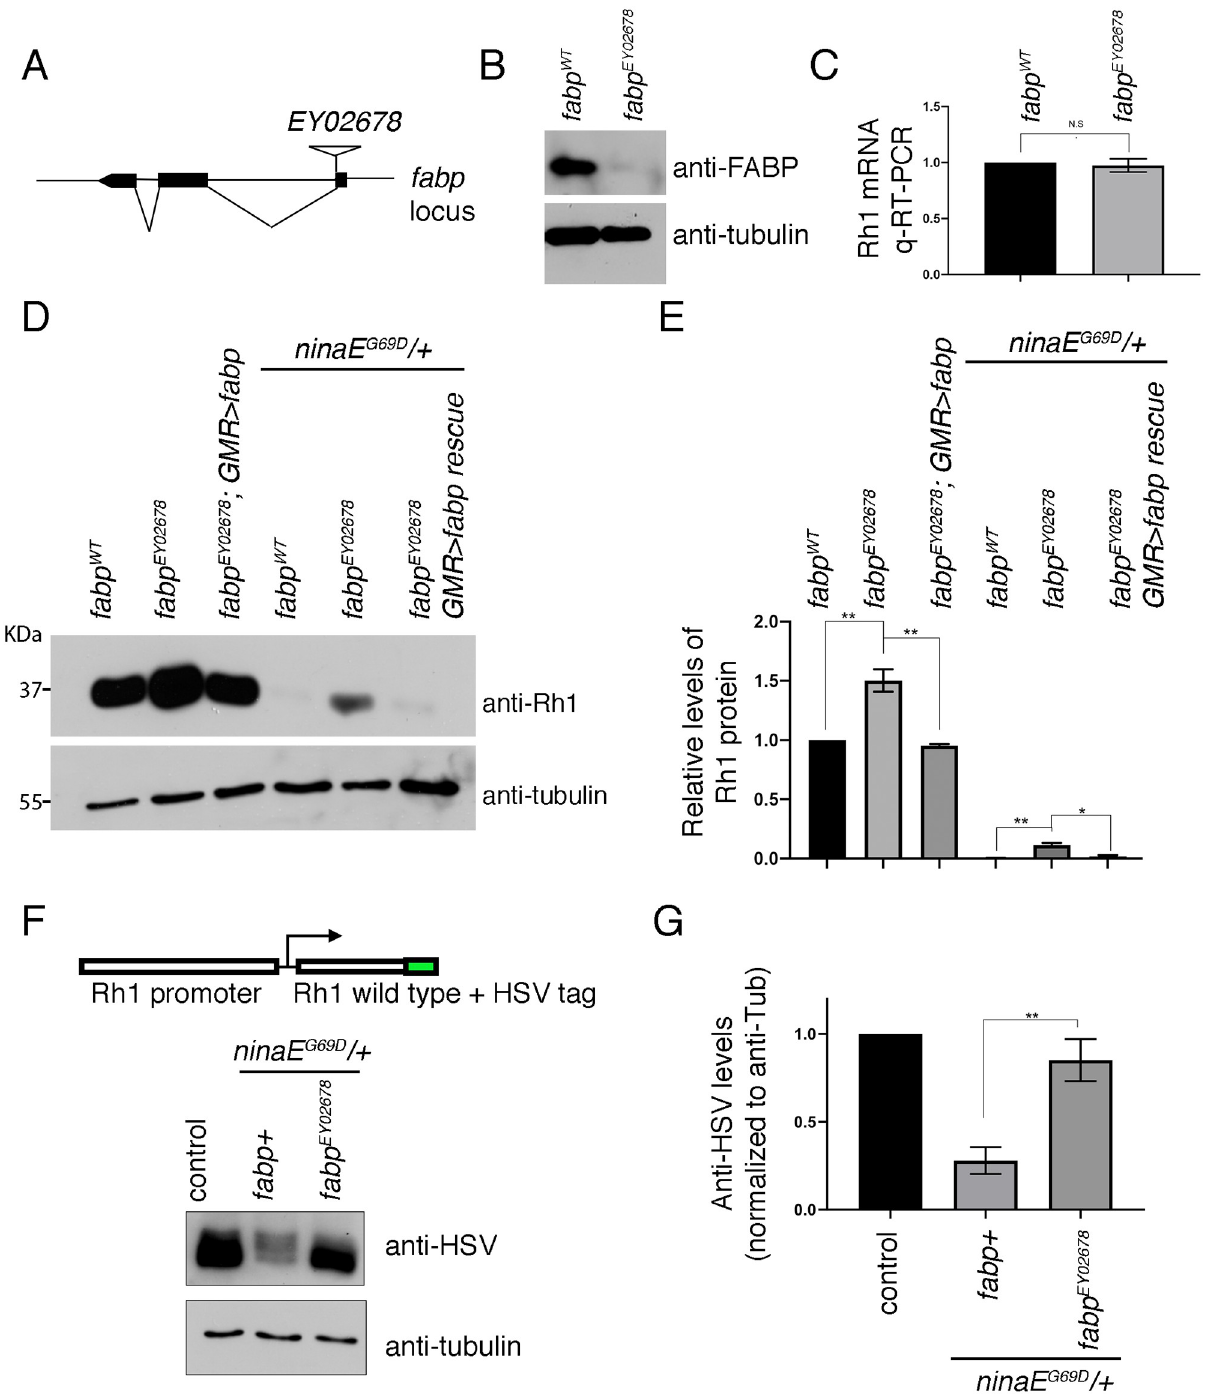
Fig 4. Loss of fabp enhances Rhodopsin-1 protein levels. (A) A schematic diagram of the fabp locus and the EY02678 P-element insertion site. (B) Evidence that fabp EY02678 is a loss-of-function allele. Shown are western blots of FABP and β -Tubulin from adult fly head extracts of wild type or fabp EY02678 flies. (C) Rh1 mRNA q-RT-PCR from fly heads of fabp wild type control (left) and fabp EY02678 mutants (right). (D) Western blot of Rhodopsin-1 (Rh1) and β -Tubulin from fly heads extracts of the indicated genotypes: fabp wild type (lane 1), fabp EY02678 mutants (lane 2), fabp EY02678 mutants rescued with GMR-Gal4 driven uas-fabp expression (lane 3). Lanes 4–6 show anti-Rh1 blots in the ninaE G69D /+ background, with fabp wild type (lane 4), fabp EY0678 (lane 5), and fabp EY02678 mutants rescued with GMR-Gal4/uas-fabp (lane 6). (E) Quantification of relative Rh1 band intensities as normalized to β -Tubulin. (F) Western blot of HSV-tagged transgenic Rh1 from head extracts. The schematic diagram (top) shows that HSV-tag is